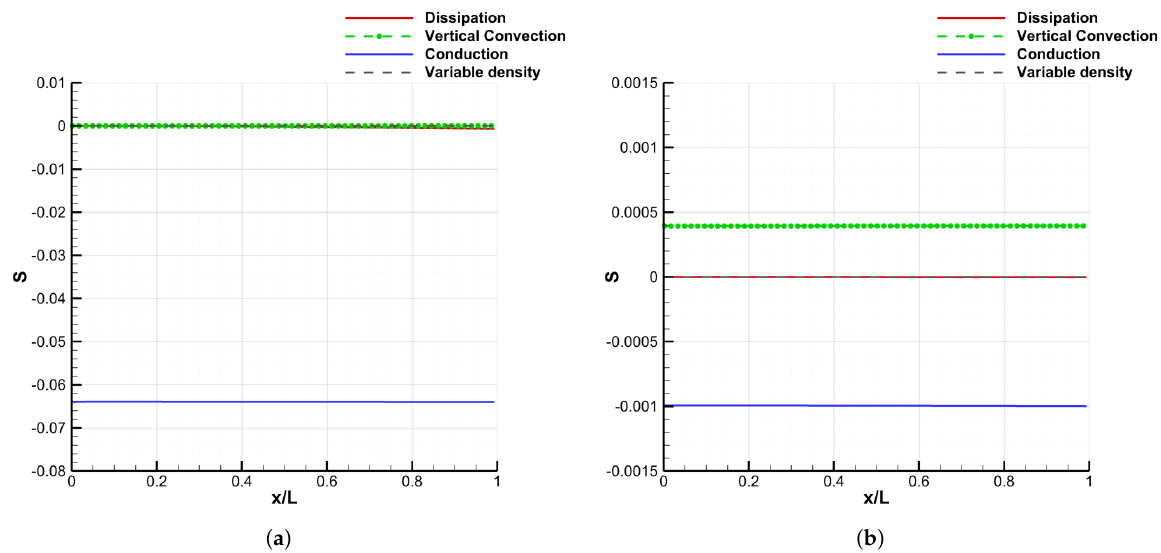
Figure 3. Source terms for N = 5. ( a ) Equation (1), ( b ) Equation (2). Test-case 1, N x = 256. Figure 4 confirms that self-similar temperature profiles are produced by BLIM2D, and here for N = 4: all the temperature profiles are superimposed at every point of the